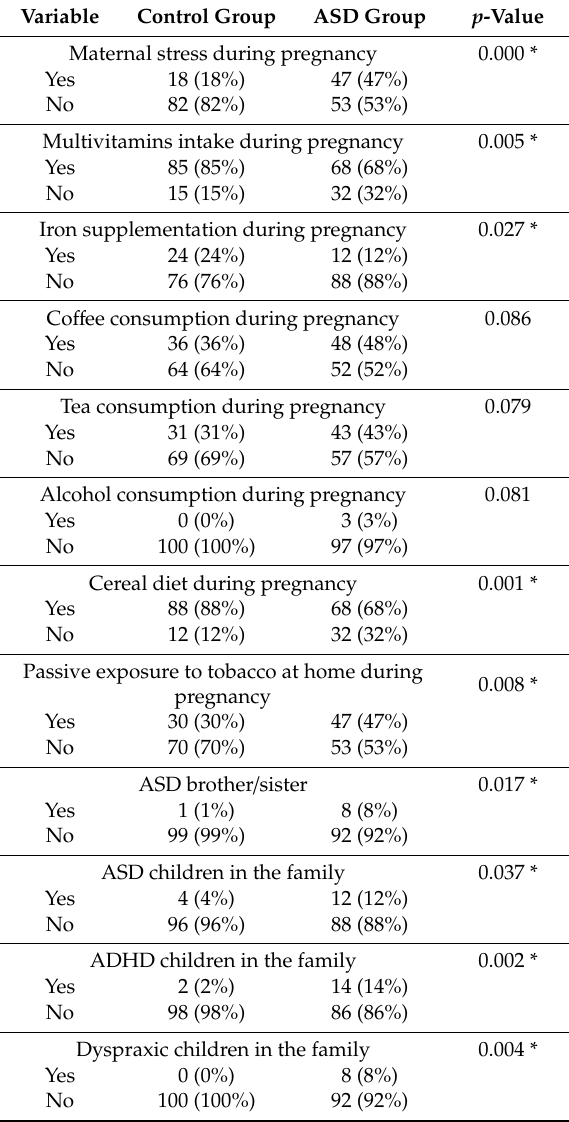
Table 3. Factors by bivariate analysis for